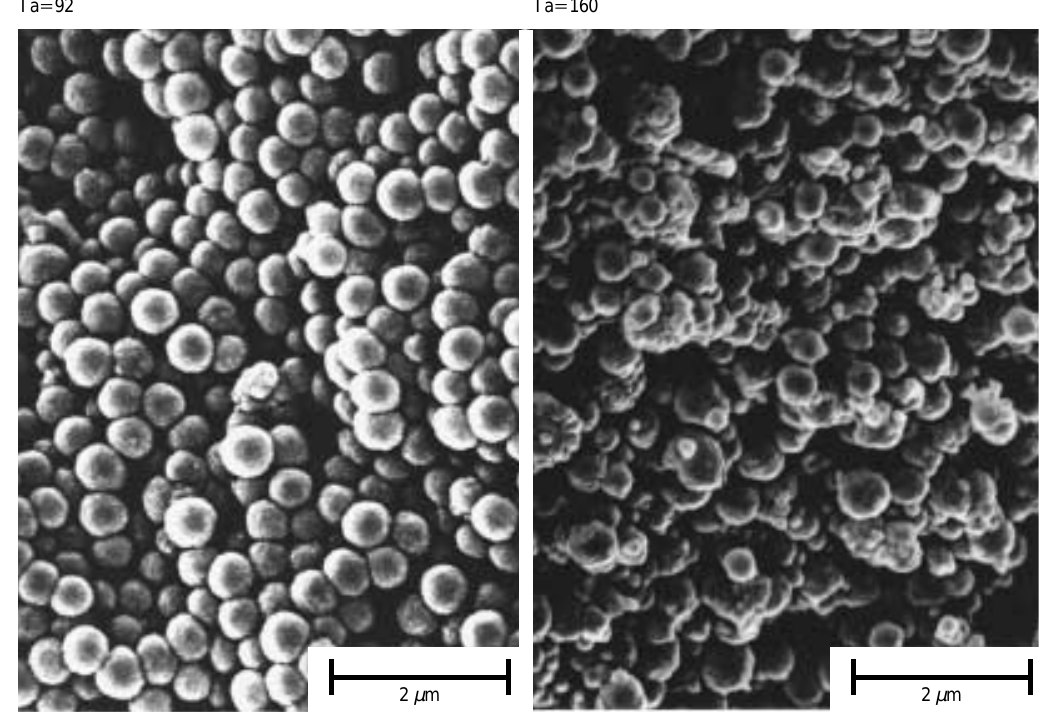
Fig. 7 Effect of Ta number on the agglomeration of